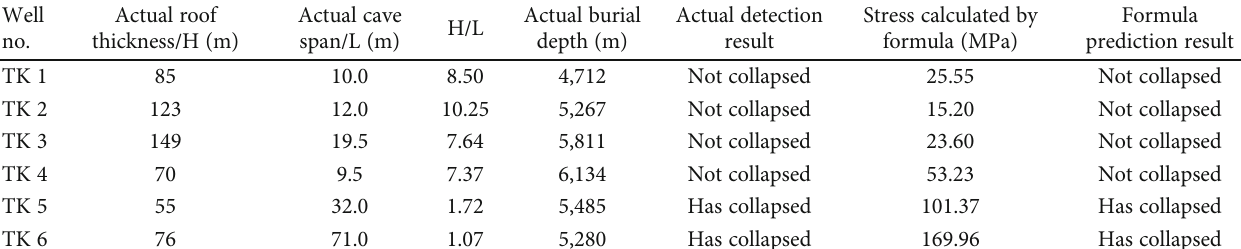
Table 7: Comparison of diagram prediction results and actual detection